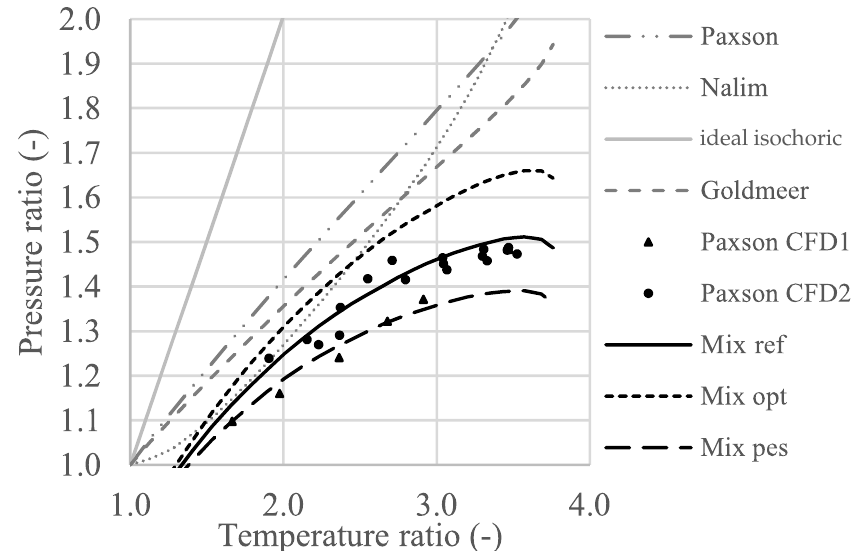
Figure 2. Pressure ratio as a function of the temperature ratio for the analyzed PGC models [19]. opt, optimistic; pes, pessimistic.